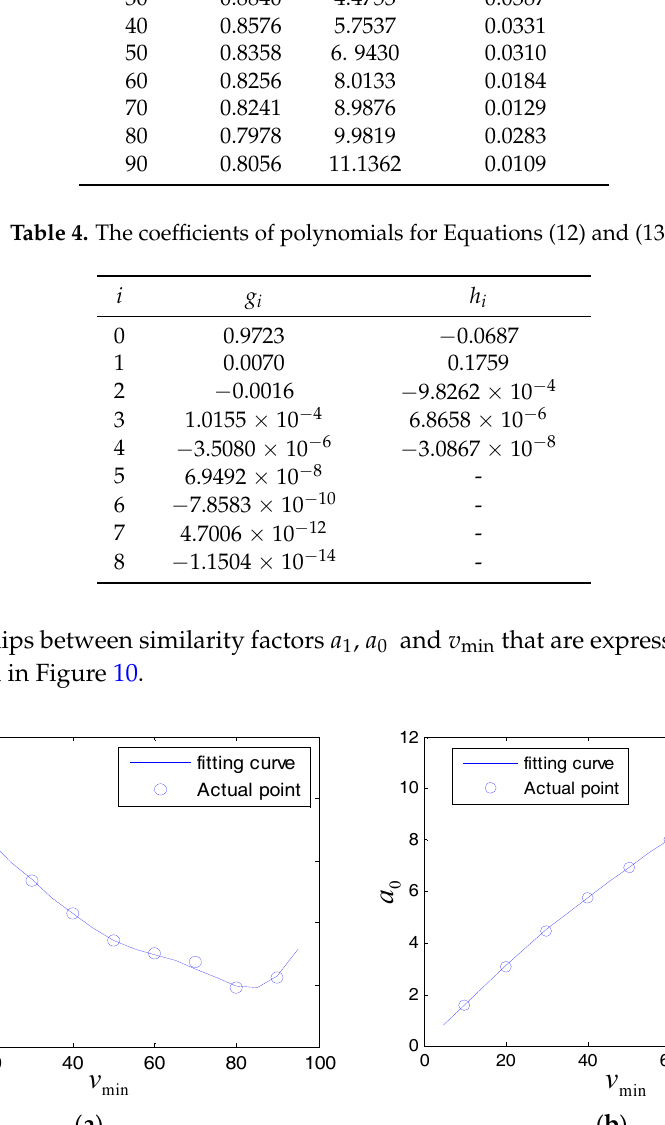
Table 3. The identification of Equation (3). ( v 0